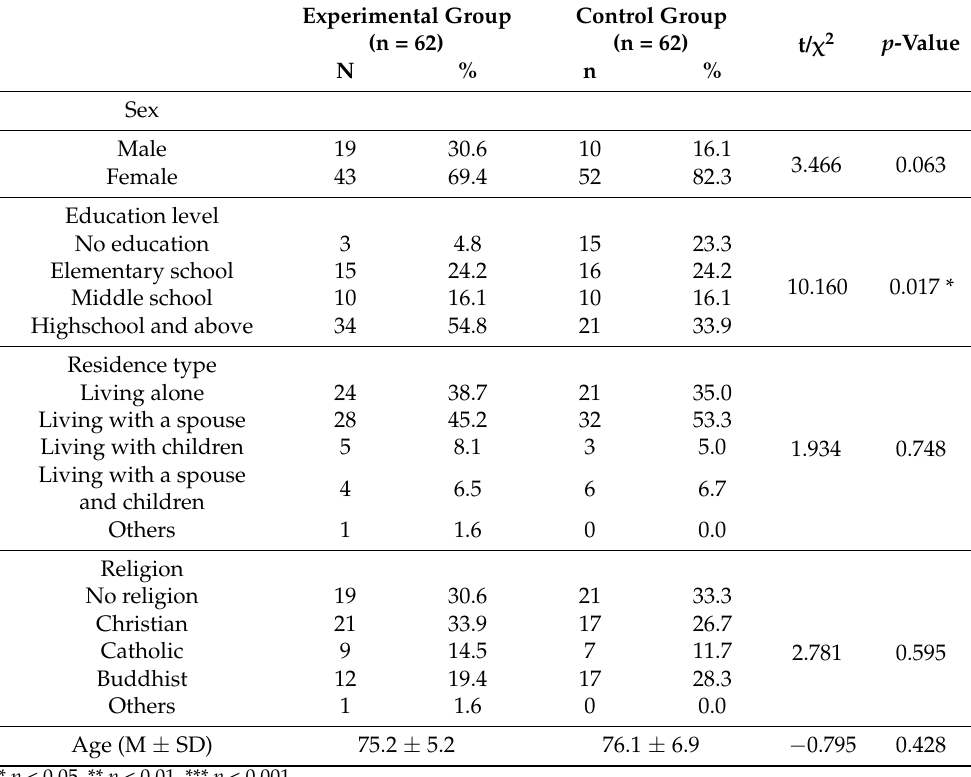
Table 2. Demographic characteristics of